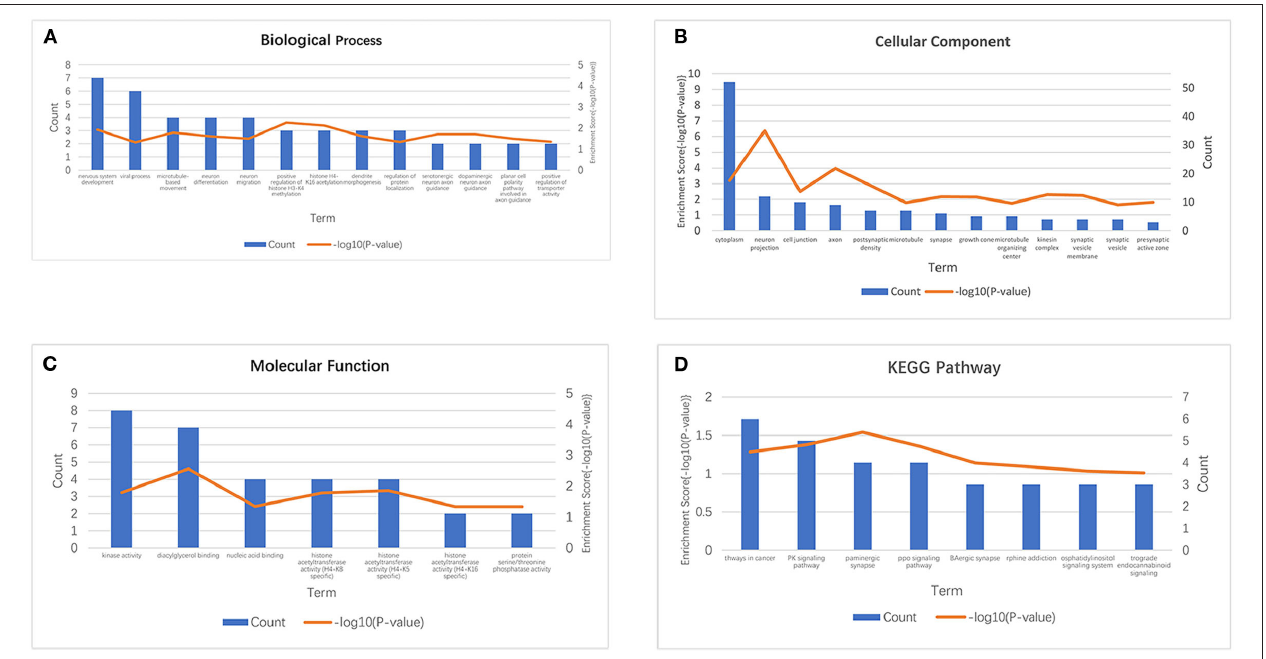
FIGURE 7 | GO terms and the KEGG pathway. (A) GO enrichment of target genes in biological process ontology ( P < 0.05). (B) GO enrichment of target genes in cellular component ontology ( P < 0.05). (C) GO enrichment of target genes in molecular function ontology ( P < 0.05). (D) The top 8 pathways related to the differentially expressed genes by the KEGG database analysis. BP, biological process; CC, cellular component; GO, gene ontology analysis; KEGG, Kyoto Encyclopedia of Genes and Genomes; MF, molecular function.